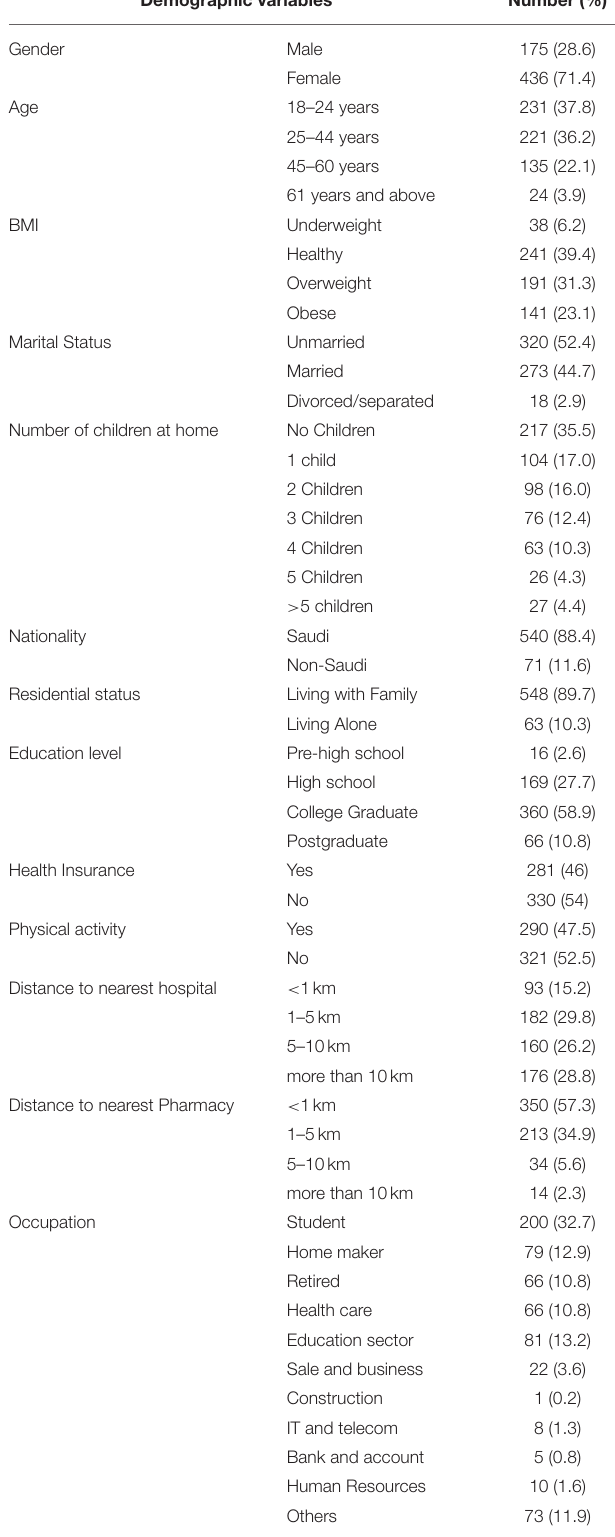
TABLE 1 | Socio-Demographic characteristics of the study participants. Demographic